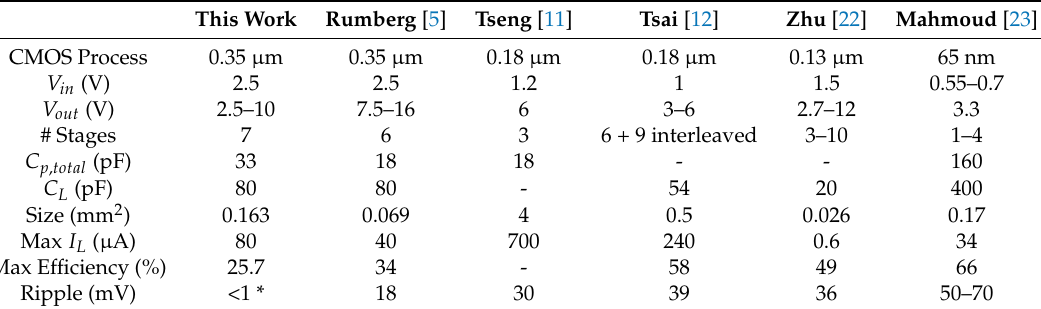
Table 2. Comparison of low-ripple charge